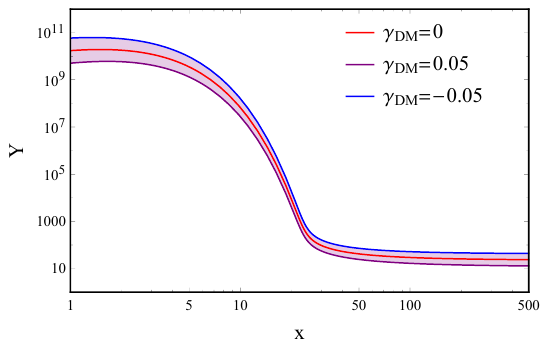
Figure 3 . The plot of Y by x for several values of γ DM